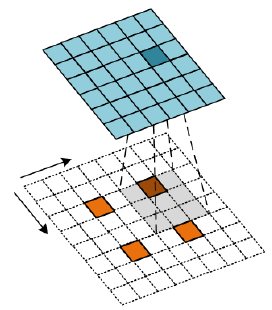
Figure 5. Convolution process of transposed convolution layer. Figure 5 . Convolution process of transposed convolution layer.